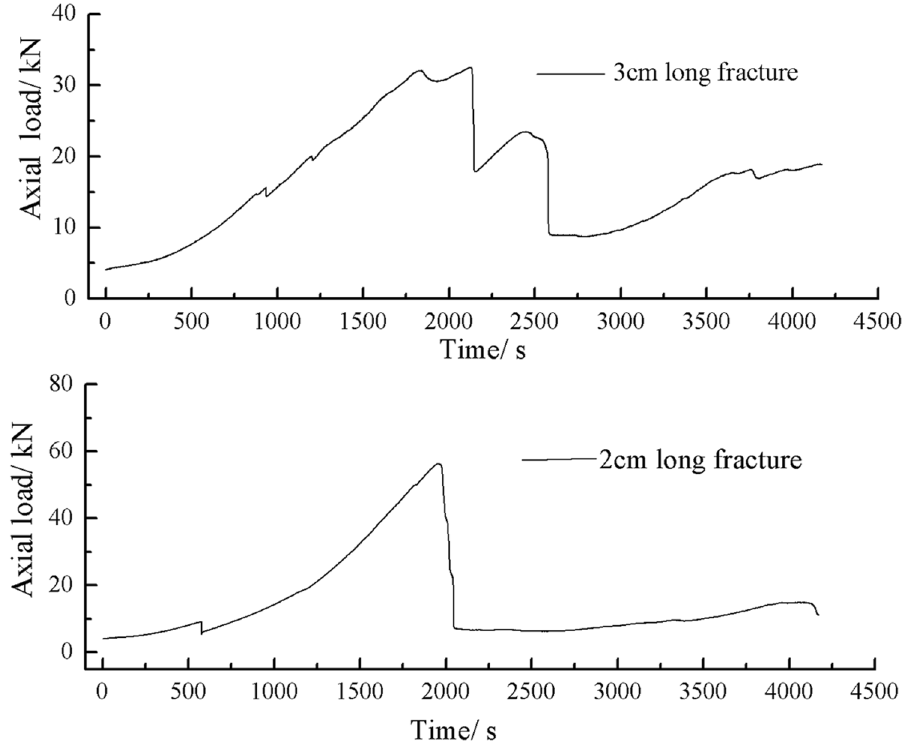
Figure 41. Axial load-Time curves for rock masses with two fracture lengths.